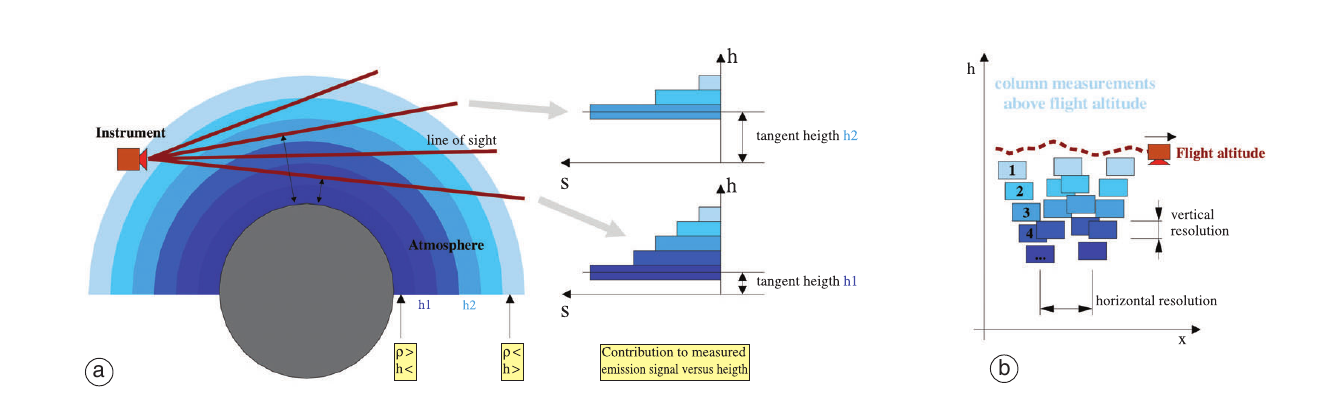
Fig. 3a,b. The limb sounding observation geometry: a) vertical resolution; b) horizontal